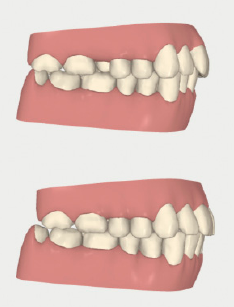
Figure 17. Case 2: digital lateral views before and after the space closure.